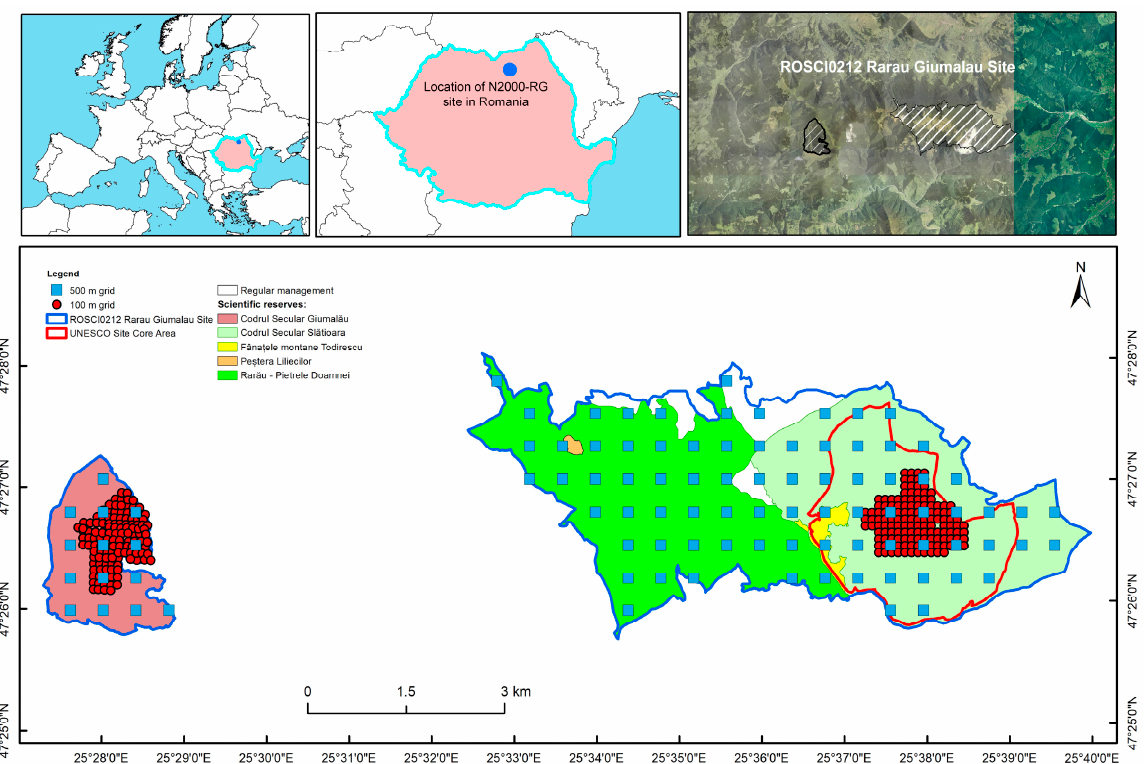
Figure 1. Location of N2000-RG site, reserves inside the study area and design of the research network (reserve boundaries from http://mmediu.ro/articol/date-gis/434, accessed on 6 July 2022). Maps were created using ArcGIS ® software by Esri. ArcGIS ® and ArcMap™ are the intellectual property of Esri and are used herein under license. Copyright © Esri. All rights reserved. For more information about Esri ® software, please visit www.esri.com (accessed on 6 July 2022). Table 1. Summary of reserves inside the study